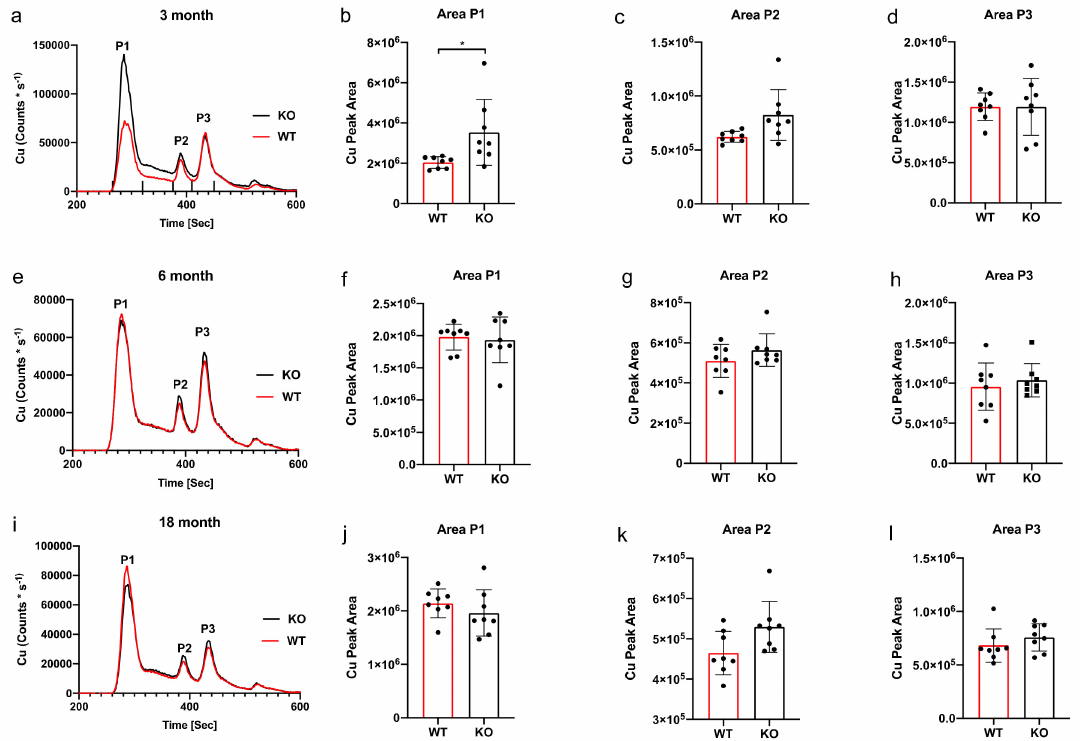
Figure 3. ICPMS and area under the curve Cu63 analysis. A di ff erence in Cu was observed between WT and KO mice at the 3-month time point chromatogram ( a ). The ticks above the x-axis indicate the integration windows for the AUC analysis. Analysis of peak area 1 ( b ) revealed a significant decrease (* p = 0.02) between WT and KO, however peaks 2 and 3 revealed no di ff erence ( c , d ). No significant di ff erence in Cu was observed between WT and KO mice at the 6-month time point chromatogram ( e ). A result reflected in the area under the curve (AUC) analysis of peak 1 ( f ), peak 2 ( g ) and peak 3 ( h ). No significant di ff erence in Zn was observed between WT and KO mice at the 6-month time point chromatogram ( i ). A result reflected in the area under the curve (AUC) analysis of peak 1 ( j ), peak 2 ( k ) and peak 3 ( l ). Dot plots and bar graph show the mean and SD, peak area statistical comparison one-way ANOVA Sidak’s multiple comparison